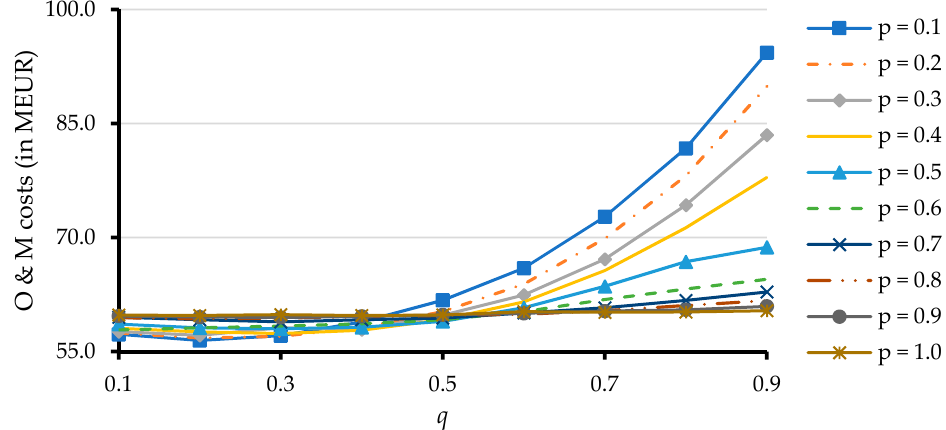
Figure 8. O & M costs for different 𝑞 and 𝑝 (in MEUR). Graphic representation.